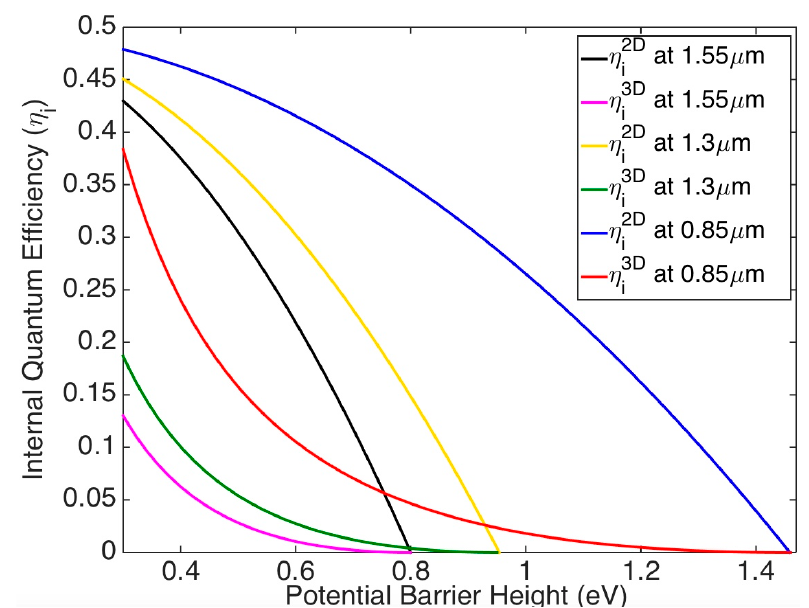
Figure 3. Comparison between internal quantum efficiency of 3D, Equation (2), and 2D, Equation (5), materials for three different wavelengths of 0.85, 1.3 and 1.55 μ m.